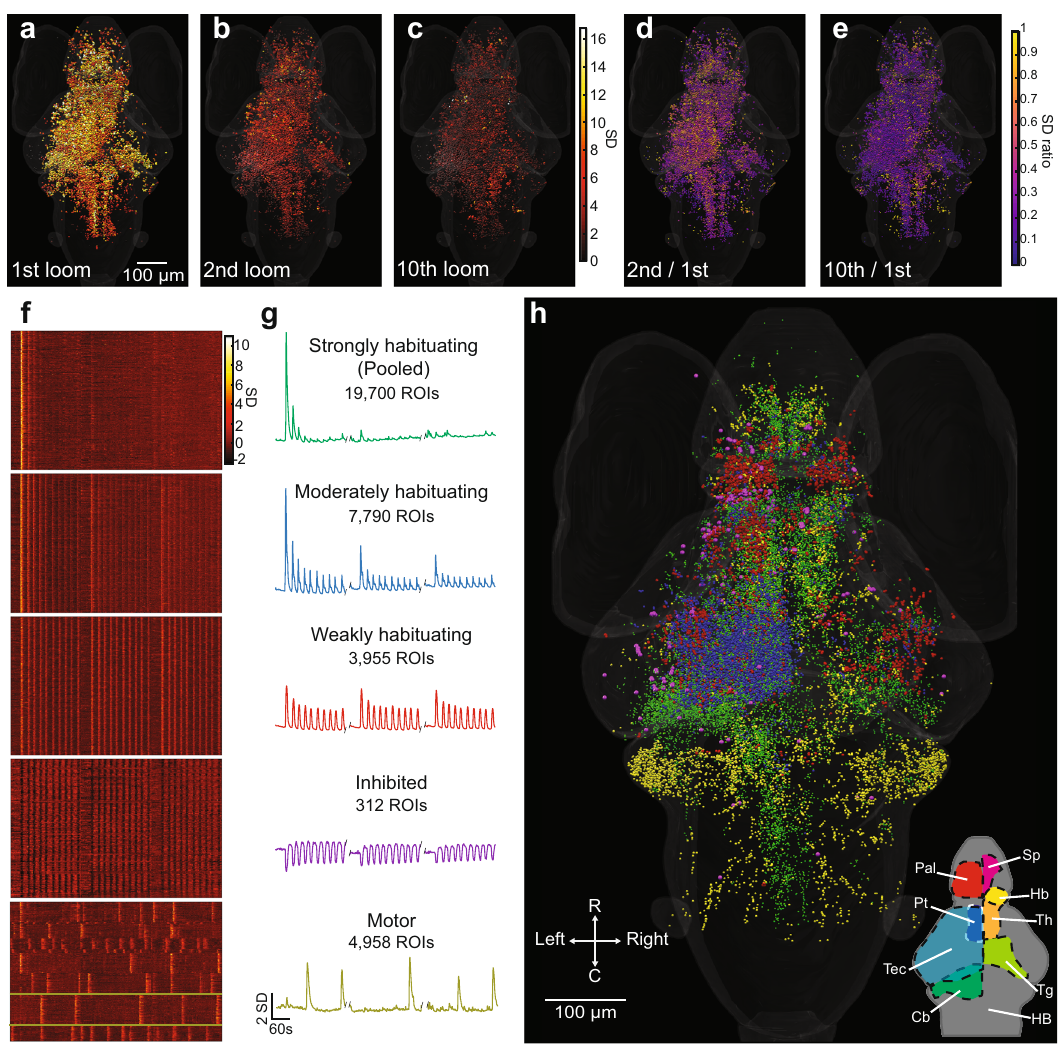
Fig. 2 Activity of individual ROIs and their functional clusters during habituation. a Responses of ROIs across the brain to a loom stimulus, color-coded for the normalized intensity of their response. b , c The same ROIs ’ responses to the second and tenth looms. d , e The degree of habituation in each of these ROIs in the second and 10th trials, calculated as the ratio of response to the fi rst loom. This analysis was restricted to ROIs showing clear responses (with a coef fi cient of determination ( r 2 value) > 0.5 for the linear regression between their response and a regressor simulating a calcium signal) for the fi rst loom stimulus. Raster plots ( f ) and mean response traces ( g ) of the ROIs composing each of fi ve functional clusters, with a clear correspondence to the three blocks of ten stimuli. The x axis scale at the bottom of g also applies to f . h Anatomical locations for the ROIs belonging to each functional cluster (colors matching the mean traces in g ). Since different animals startled in different trials, we identi fi ed the motor cluster using a different regressor for each animal. The mean responses are shown for a single animal in this cluster in g , with yellow lines indicating the relevant neurons from that animal in f . A rotation of h can be found in Supplementary Movie 1, and the distributions of these clusters are detailed in virtual sections in Supplementary Fig. 5. Data shows the pooled responses of 11 larvae to the f20 stimulus train. Relevant anatomical brain regions are indicated in the bottom right corner of h , each shown for only one side of the brain. Pallium, Pal; subpallium, Sp; thalamus, Th; habenula, Hb; pretectum, Pt; tectum, Tec; tegmentum, Tg; cerebellum, Cb; and hindbrain, HB. R, rostral; C,